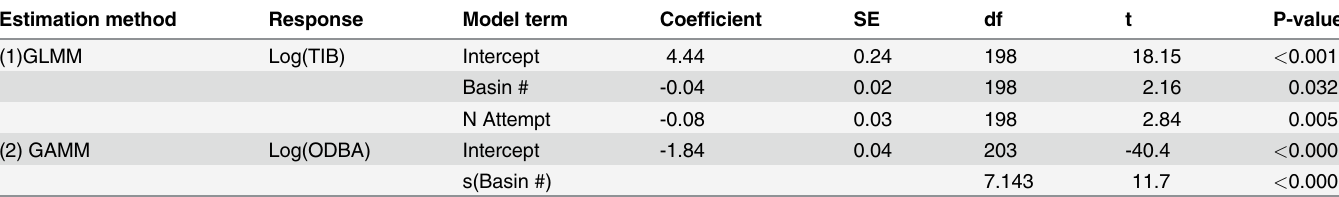
Table 1. Fixed effects from the top GLMM to explain TIB. Random intercept variance was 0.257. Estimation method